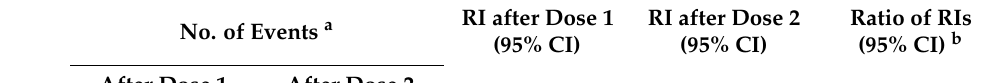
Table 4. The ratios of relative incidences and relative incidences of venous thromboembolism after two doses of COVID-19 vaccination, stratified by reported